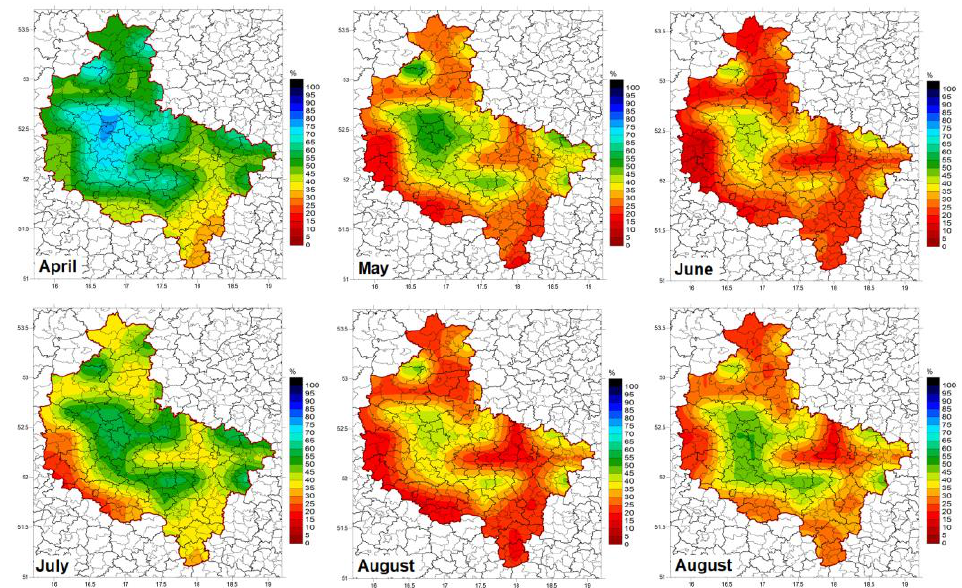
Figure 5. Soil moisture index [%] in the 7 – 28 cm layer in the following months of the growing season (April – September) 2018 .